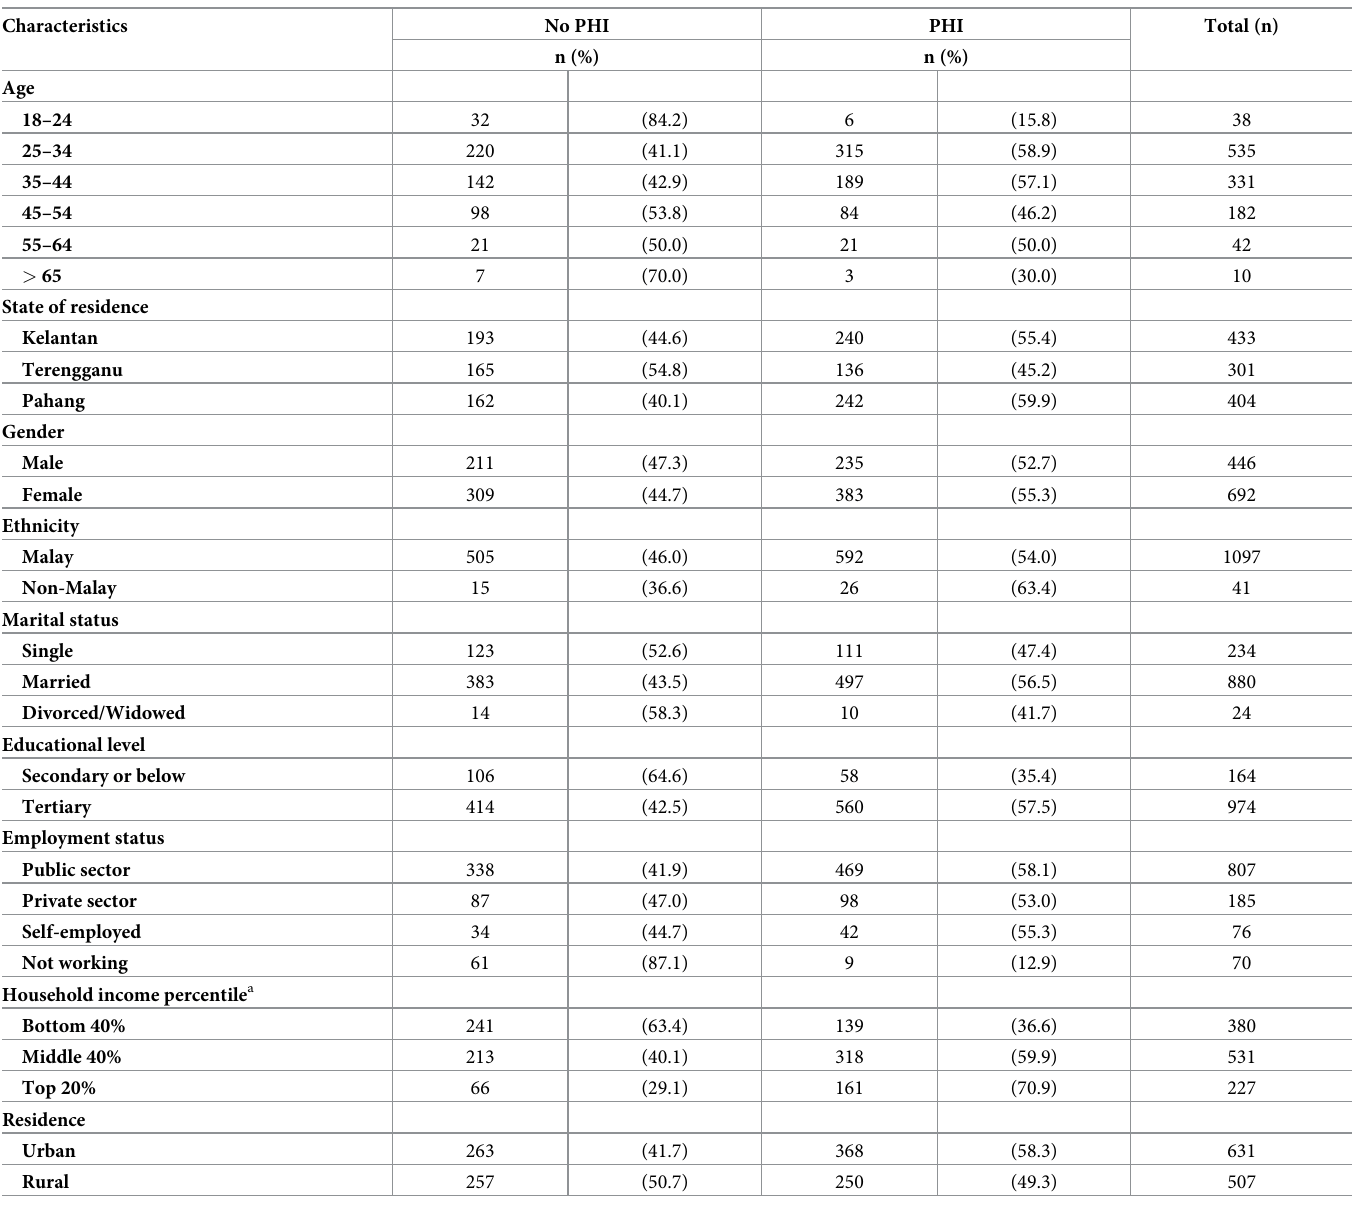
Table 1. Sociodemographic characteristics of the study participants (n =